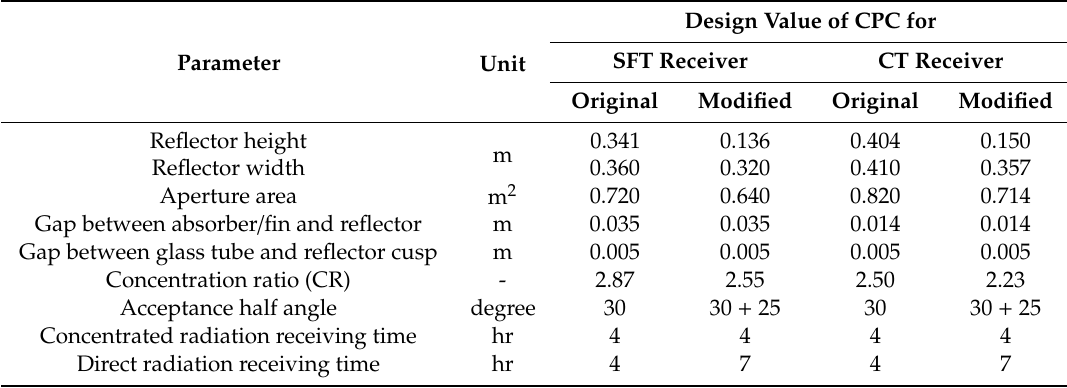
Table 2. Construction parameters of CPC